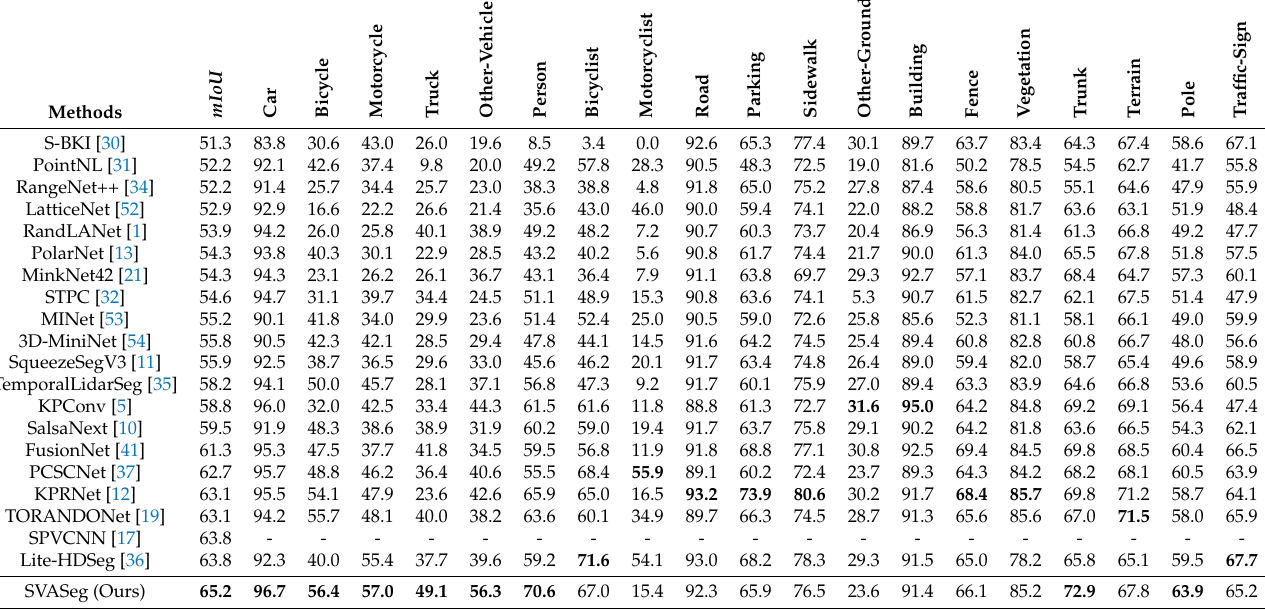
Table 2. Experimental results of our proposed SVASeg and state-of-the-art LiDAR segmentation methods on the SemanticKITTI dataset’s official leaderboard. All results were obtained from the literature or